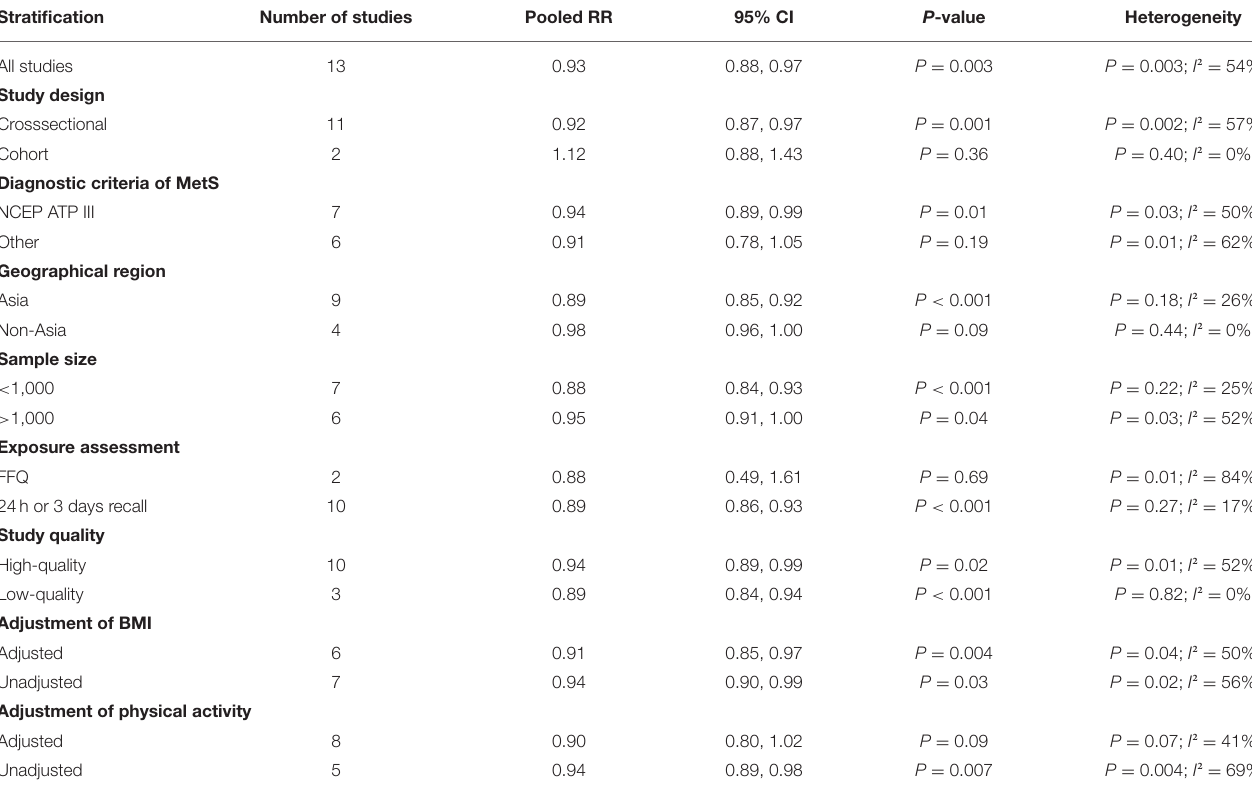
TABLE 1 | Subgroup analysis of MetS for the highest vs. lowest dietary vitamin C level